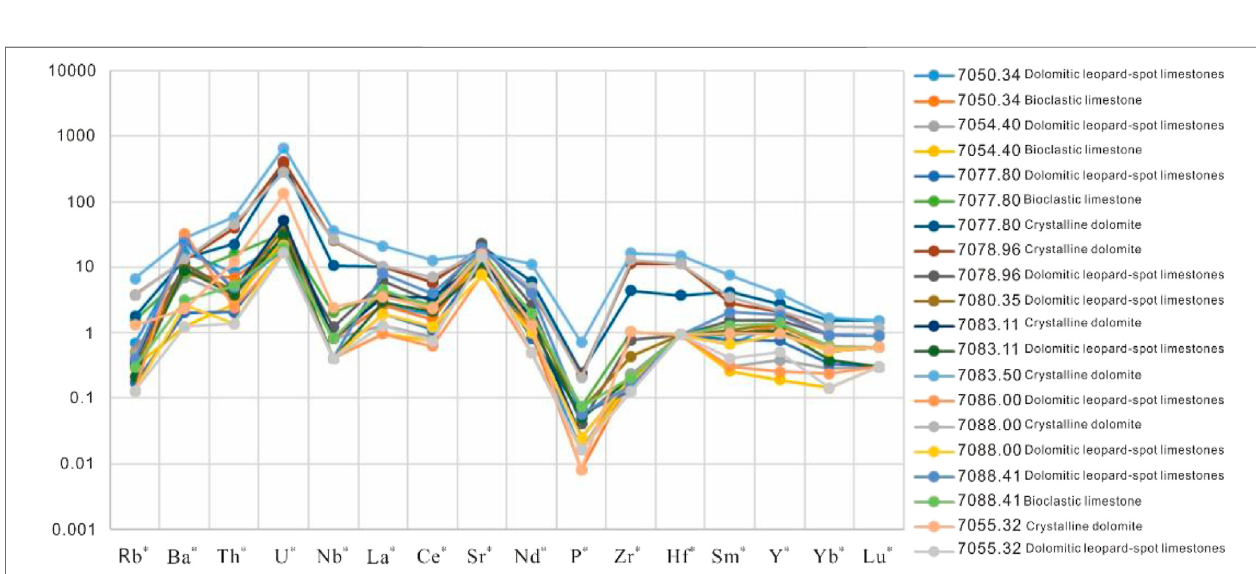
FIGURE 5 | Microelement distribution patterns in carbonate samples of Qixia Formation in the study area.